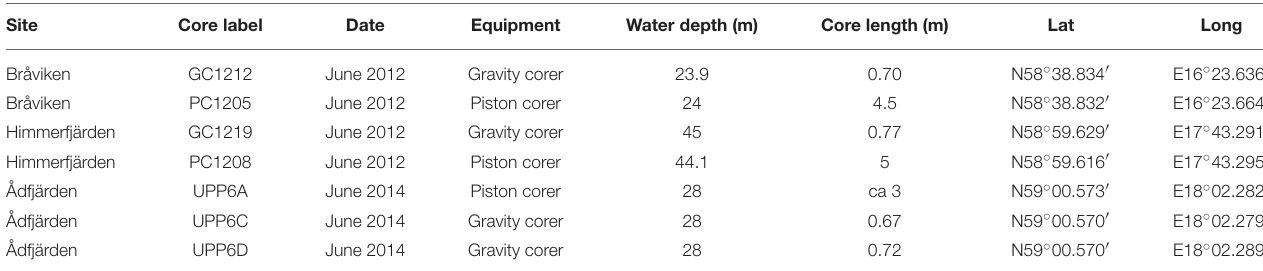
TABLE 1 | Retrieved sediment cores from Bråviken, Himmerfjärden, and Ådfjärden. Site Core label